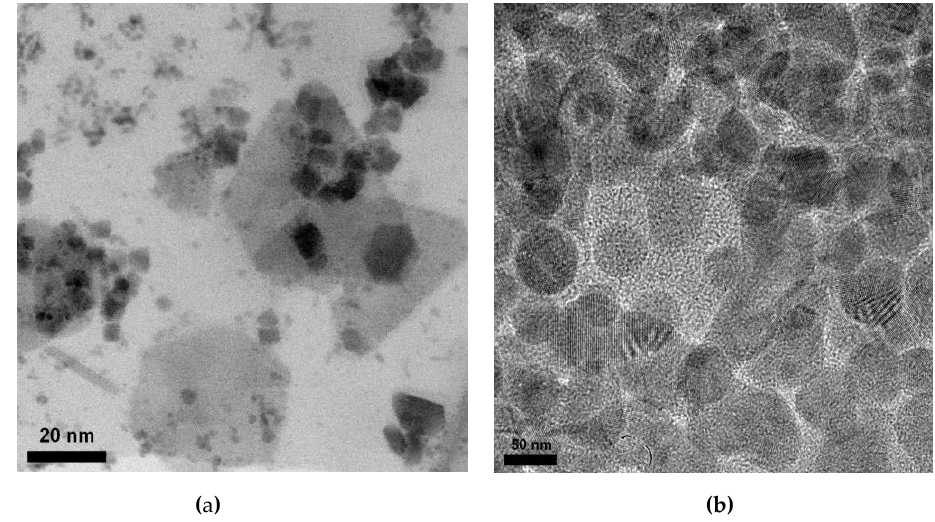
Figure 5. Transmission electron microscope (TEM) images of initial nanoparticles and after heat treatment: ( a ) Initial; ( b ) 800 °C.